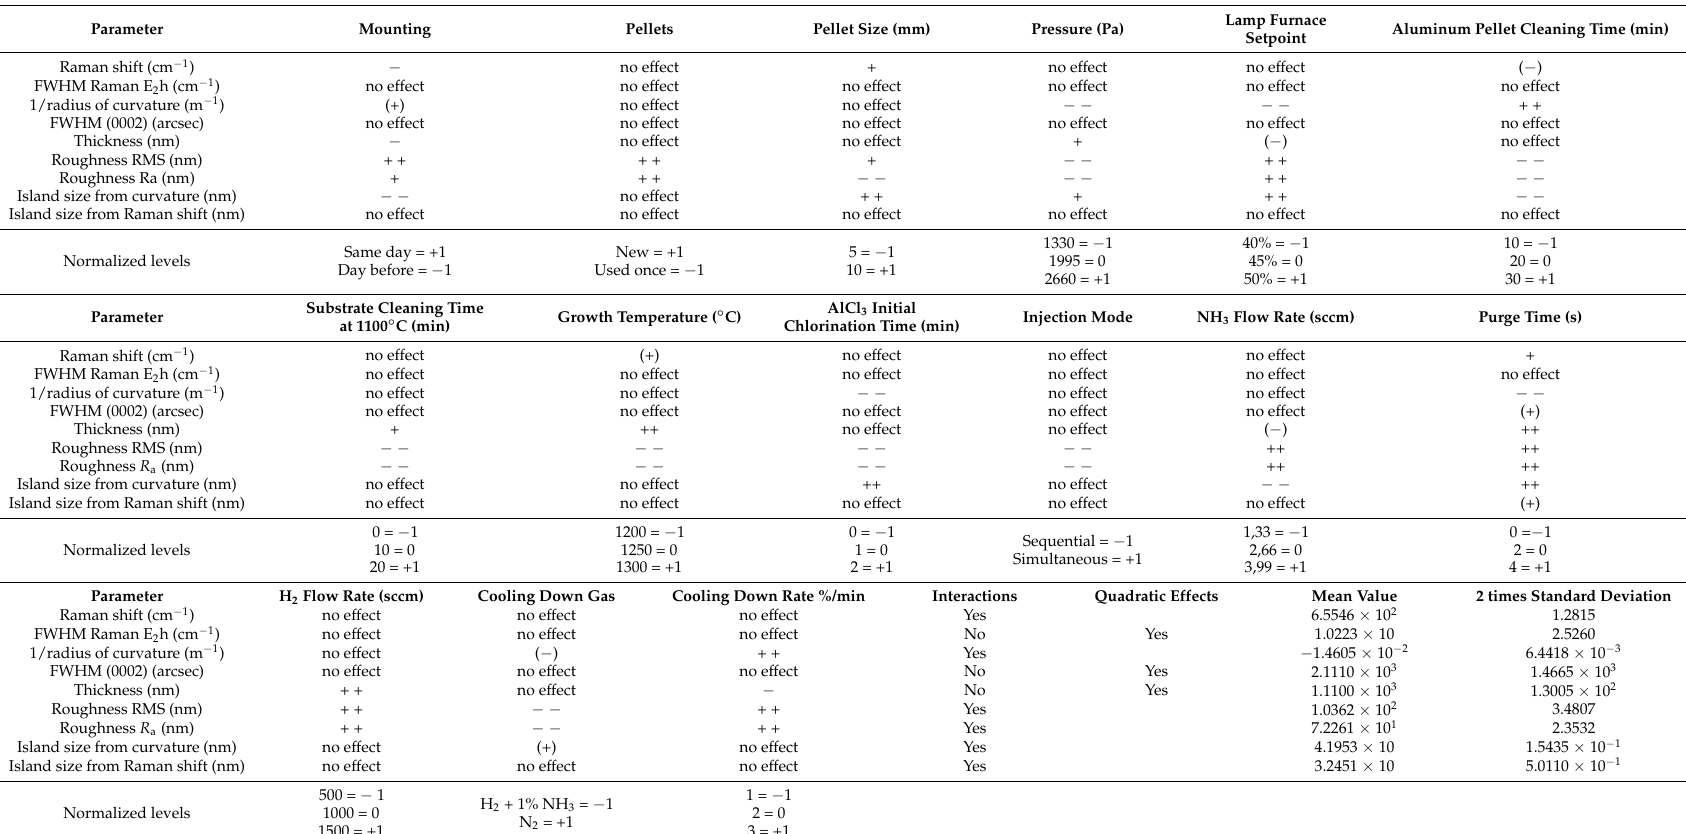
Table 3. Level of influence of parameters on outputs or